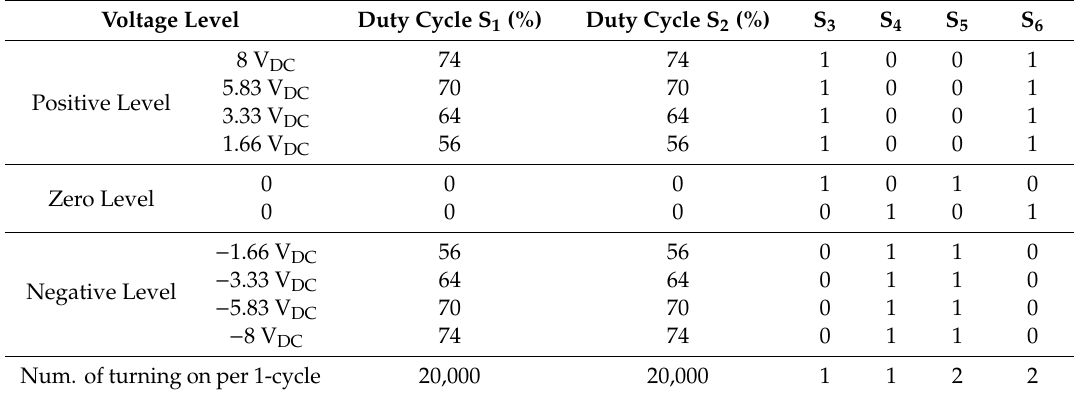
Table 4. Switching table level = 9, gain = 8.